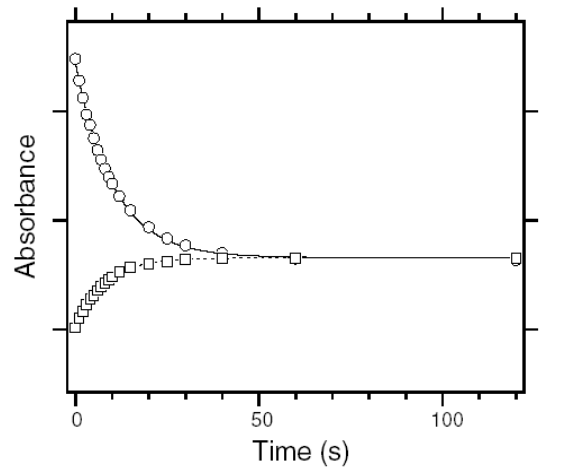
Figure 28. Absorption changes at 569 nm of the dark-adapted (open circles) and light- adapted (open squares) ASR after illumination at the isosbestic point of ASR and AT ASR (496 nm) at 277 K. Absorption changes were fitted by single exponentials (solid and 13C broken lines), and the ratio of the initial slope (light-adapted ASR/dark-adapted ASR) was 0.40:1. By taking into accounts of the contents of ASR and ASR in each state, the AT 13C ratio between ASR -to-ASR and ASR -to-ASR was determined to be 0.77 (± 0.04). 13C AT AT 13C This figure is reprinted with permission from Kawanabe et al. [71]. Copyright 2007 American Chemical